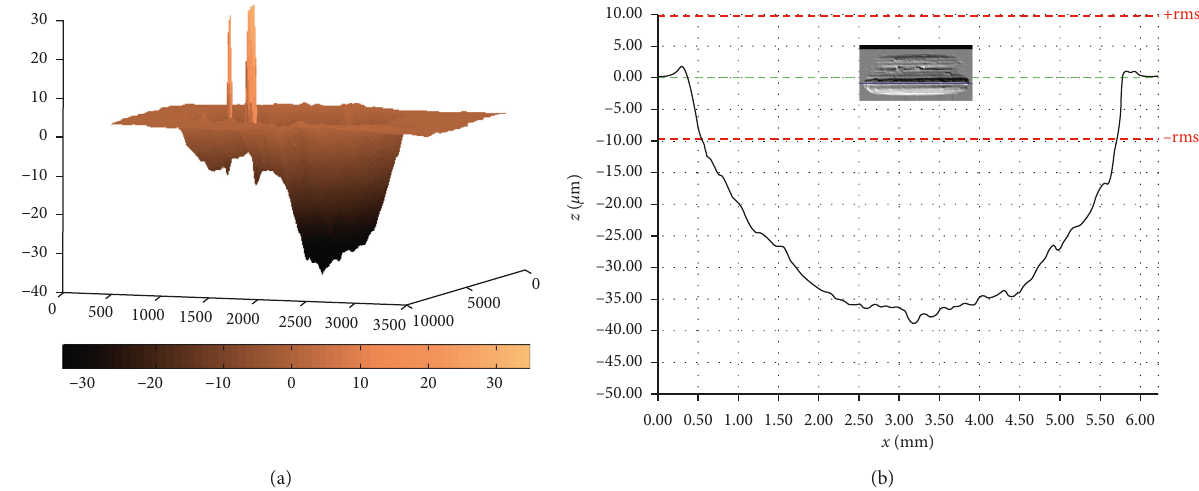
Figure 17: Three-dimensional image of the disk track of steel 1 tested at 200 ° C (a). The maximum profile depth (38 µ m) (b).